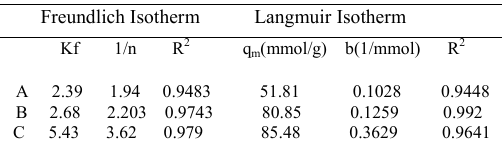
O nanosorbent, Fig. 5. Freundlich isotherms: (A) uncoated Fe 3 4 (B) BKC-coated Fe O nanosorbent and (C) CTAB-coated 3 4 O nanosorbent Fe 3 4 Table 1. Langmuir and Freundlich isotherm data: (A) uncoated Fe O nanosorbent, (B) BKC-coated Fe O nanosorbent and (C) 3 4 3 4 CTAB-coated Fe